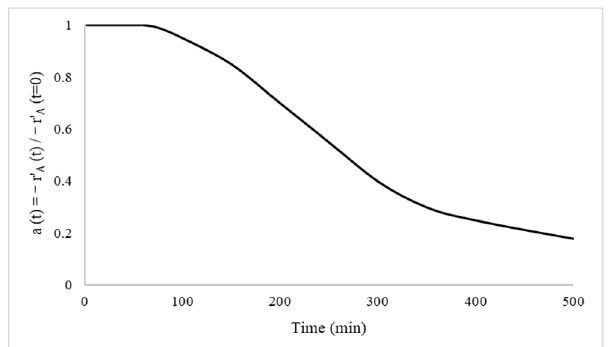
Figure 2. Catalyst activity parameter a(t) as a function of time. Reaction conditions: temperature = 30 °C; pressure = 1 bar; inlet flow = 0.05 mL/min; 0.1 g catalyst of 5 wt.% Pd on Carbon.